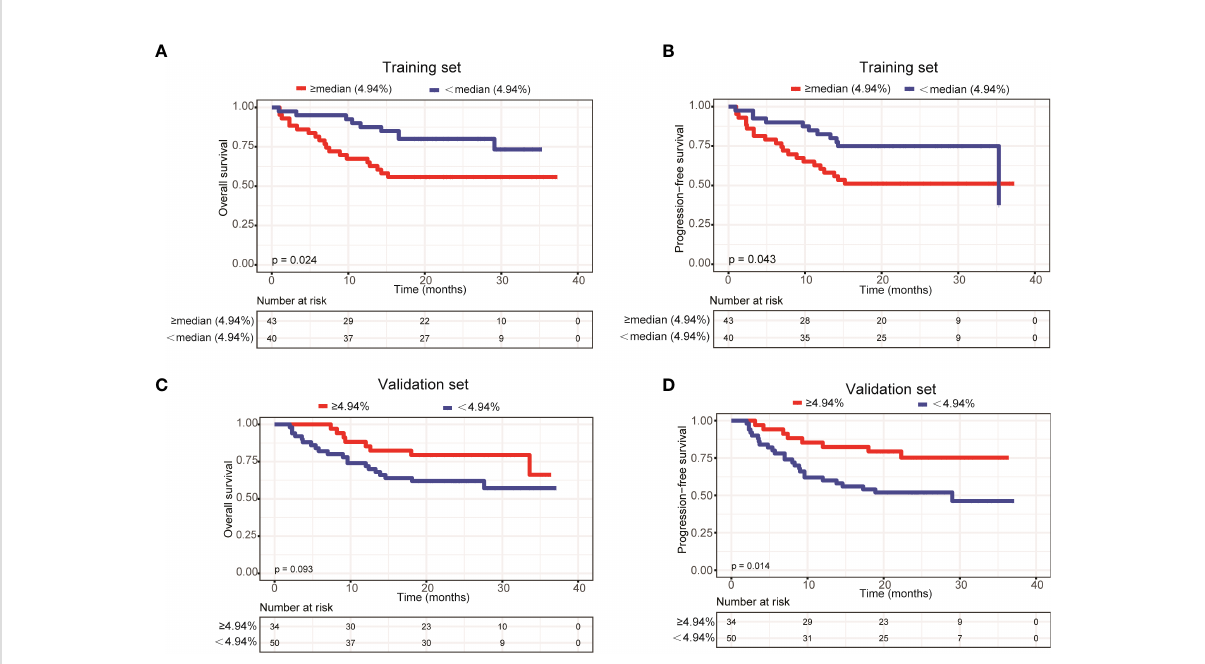
FIGURE 4 Patients with a mean VAF value ≥ 4.94% trended to have poor prognosis. Kaplan-Meier curves were applied to compare the (A) OS and (B) PFS between patients with mean VAF values ≥ 4.94% and < 4.94% in the training set. Kaplan-Meier curves were applied to compare the (C) OS and (D) PFS between patients with mean VAF values ≥ 4.94% and < 4.94% in the validation